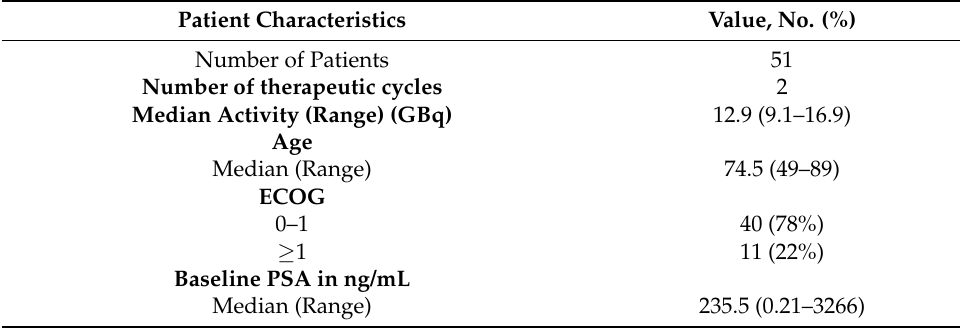
Table 1. Patient